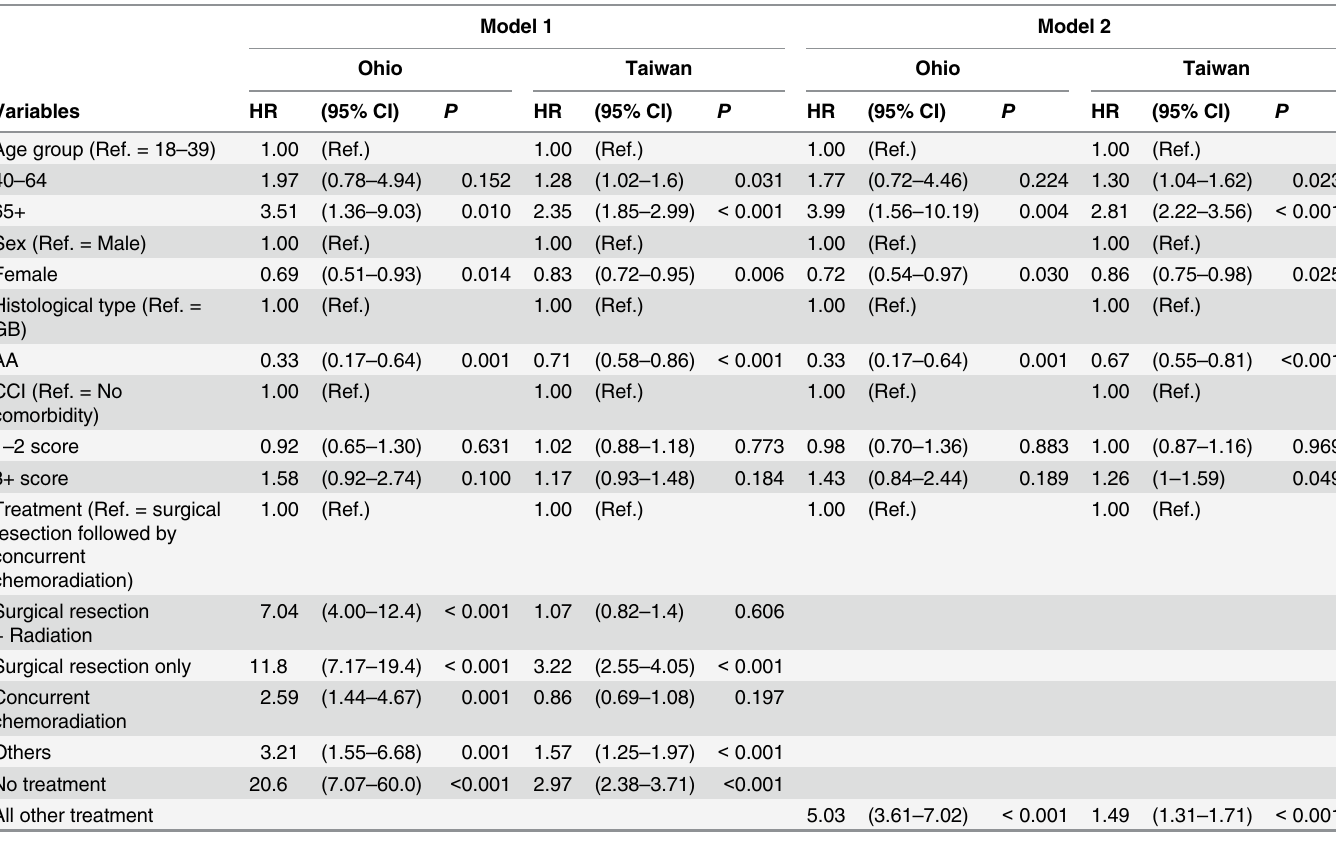
Table 3. Multivariable Survival Models of the Hazard Risk of Death of Patients Diagnosed with the High Grade Glioma for Ohio and Taiwan.